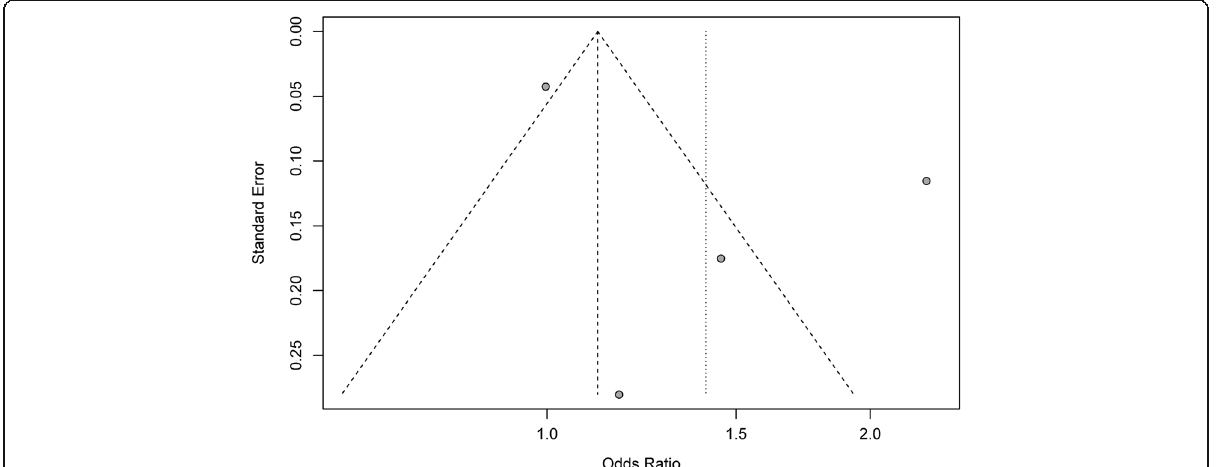
Fig. 2 Funnel plot for meta-analysis of the association of rs1126478 with dental caries assuming an additive model. The x-axis is the odds ratio, and the y-axis is the standard error of estimated effect of rs1126478 on risk of dental caries. The vertical line in the figure represents the overall estimated odds ratio. The two diagonal lines represent the pseudo 95% confidence limits of the effect estimate